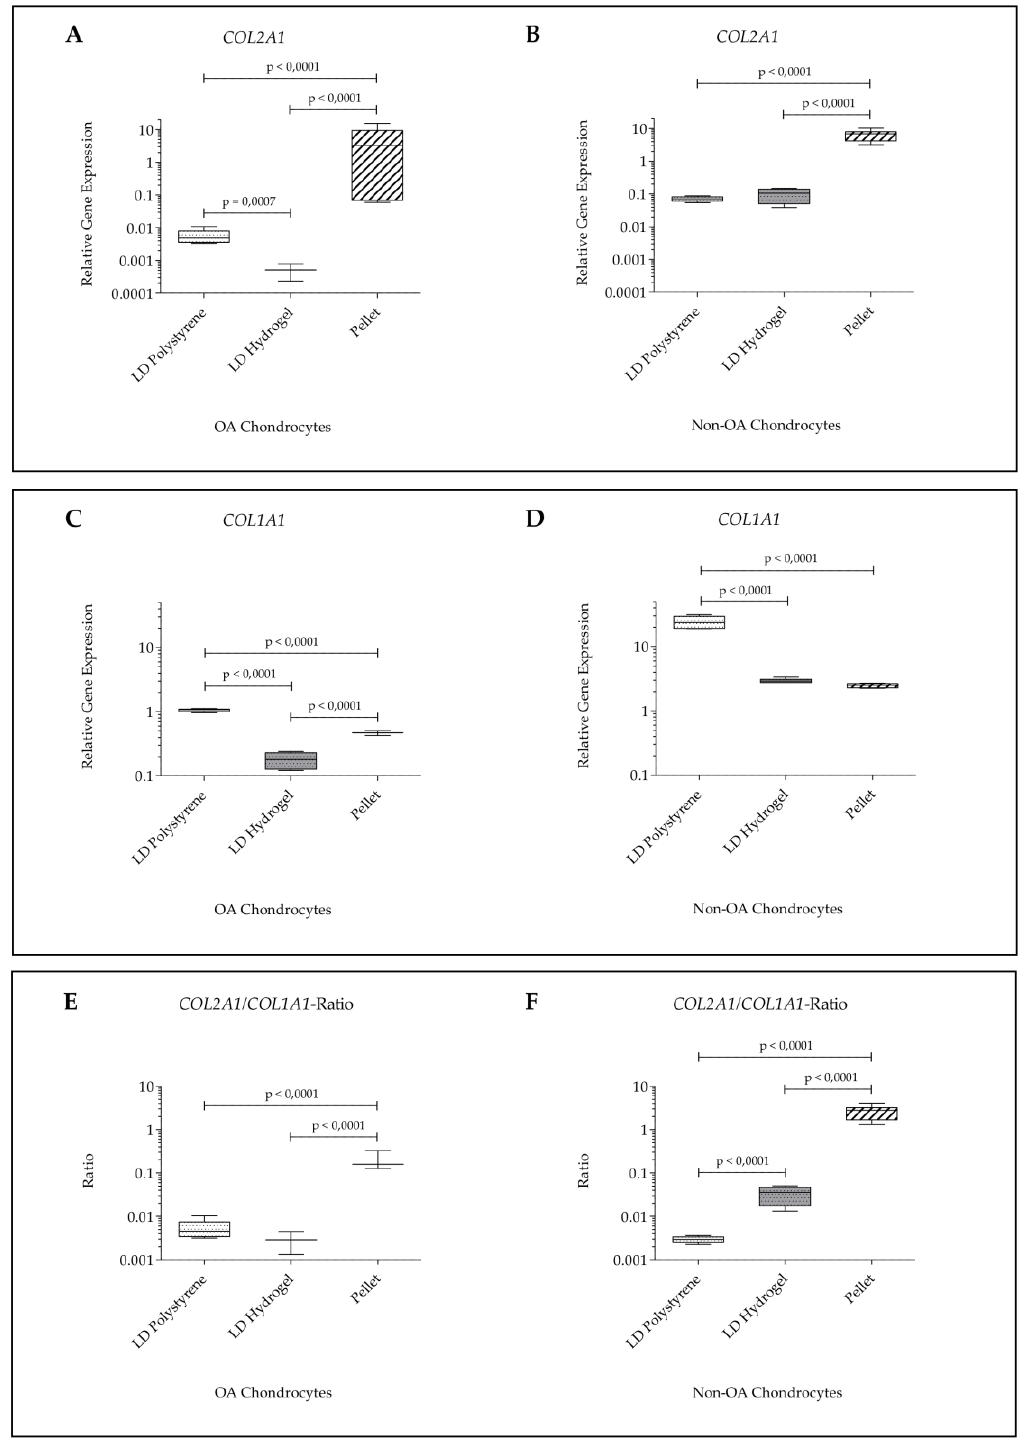
Figure 3. Validation experiments with low seeding density: relative gene expression normalized to GAPDH and day 0 (2 − ∆∆ C t ) of human articular chondrocytes after 7 days of culture in passage 2 on hydrogel, on polystyrene or in pellet culture. ( A ) COL2A1 expression in OA chondrocytes; ( B ) COL2A1 expression in non-OA chondrocytes; ( C ) COL1A1 expression in OA chondrocytes; ( D ) COL1A1 expression in non-OA chondrocytes; ( E ) COL2A1 / COL1A1 -ratio in OA chondrocytes; ( F ) COL2A1 / COL1A1 -ratio in non-OA chondrocytes.